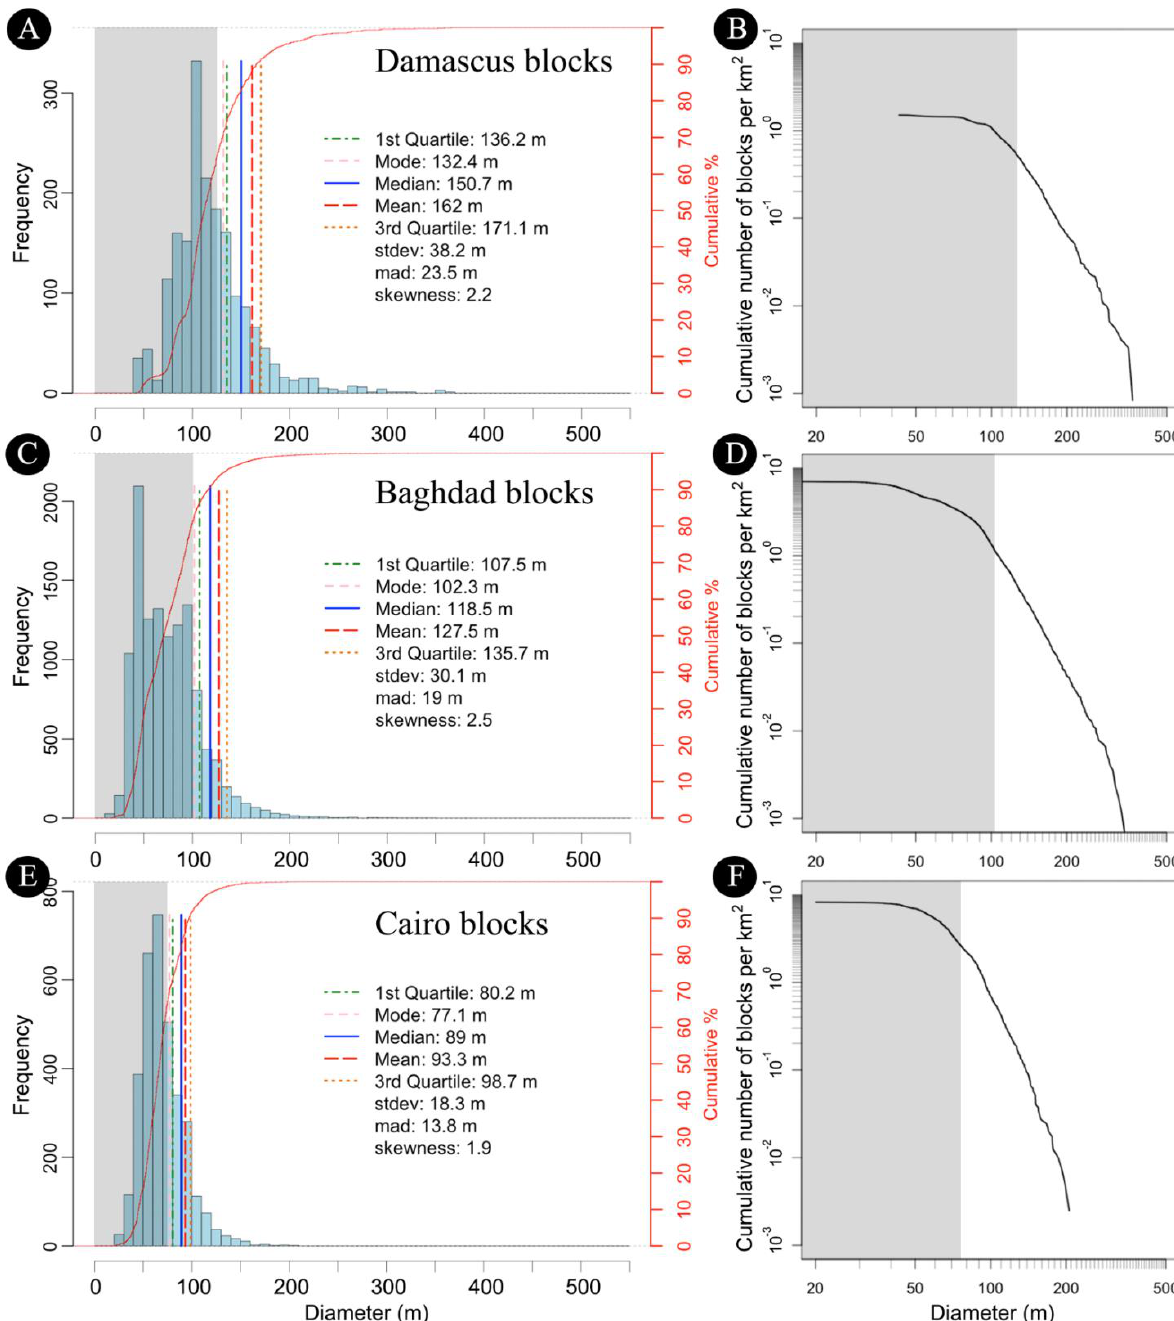
Figure 8. ( A , C , E ) Frequency histogram of the sizes identified in the Damascus, Baghdad and Cairo areas. The grey shadowed area shows the blocks that have been identified, but their diameter is smaller than 4 pixels. The main statistical properties of the right-skewed distributions are computed only for values ≥ 4 pixels. ( B , D , F ) Log-log plots showing the cumulative unbinned number of blocks per km 2 for the Damascus, Baghdad and Cairo area, respectively. As for ( A , C , E ), the grey shadowed area shows all blocks smaller than 127 m (Damascus), 101 m (Baghdad) and 74 m (Cairo).